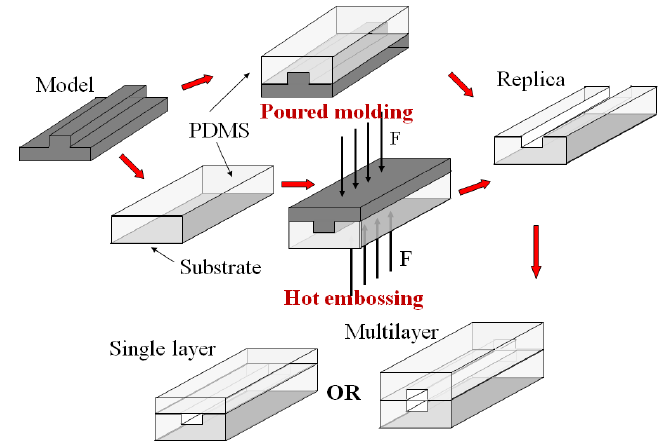
Figure 2. Steps for the fabrication of a microfluidic device by casting.